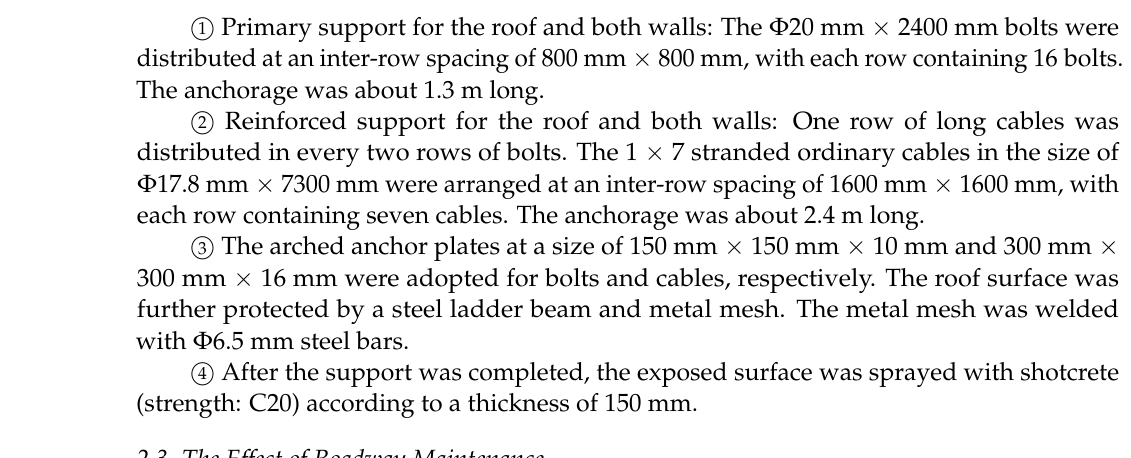
Figure 2. Cross-sectional diagram for the bolt-cable coordinated support in the return air subinclined shaft.